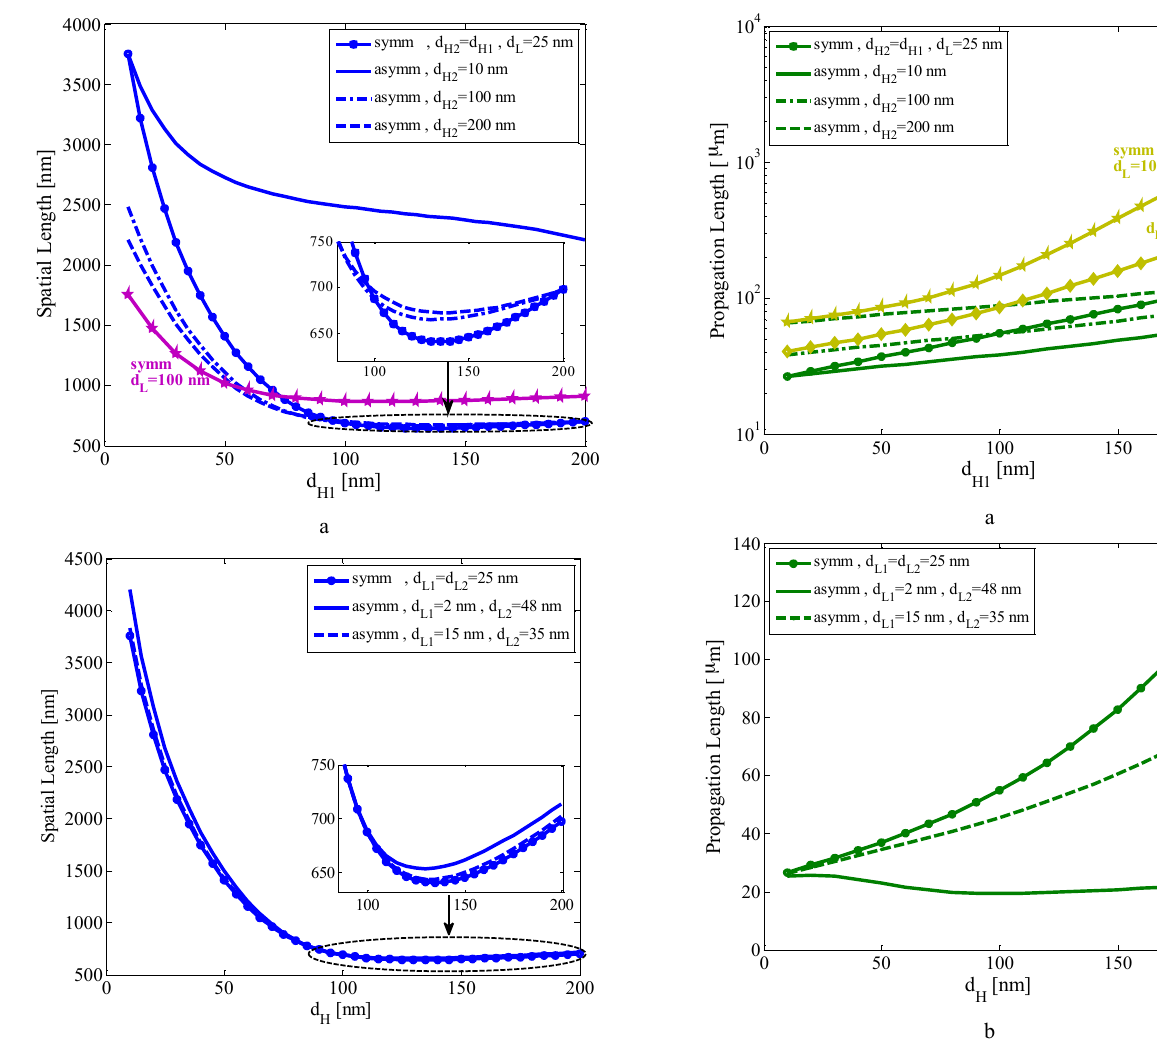
Figure 9: Propagation length of the TM 1s fundamental mode of HMIM slab waveguide for: a. asymmetry of the H-Layer Figure 8: Spatial length of the long-range TM 1s mode of HIMI slab thicknesses at d L1 =d L2 = d L =25 nm (symmetrical cases of d L =25 ,50 waveguide for: a. asymmetry of the H-Layer thicknesses at and 100 nm are included for comparison), b. asymmetry of the L- d L1 =d L2 = d L =25 nm (symmetrical cases of d L =25 and 100 nm are Layer thicknesses for d H1 = d H2 = d H =10-200 included for comparison), b. asymmetry of the L-Layer thicknesses for d H1 = d H2 = d H =10-200 nm.